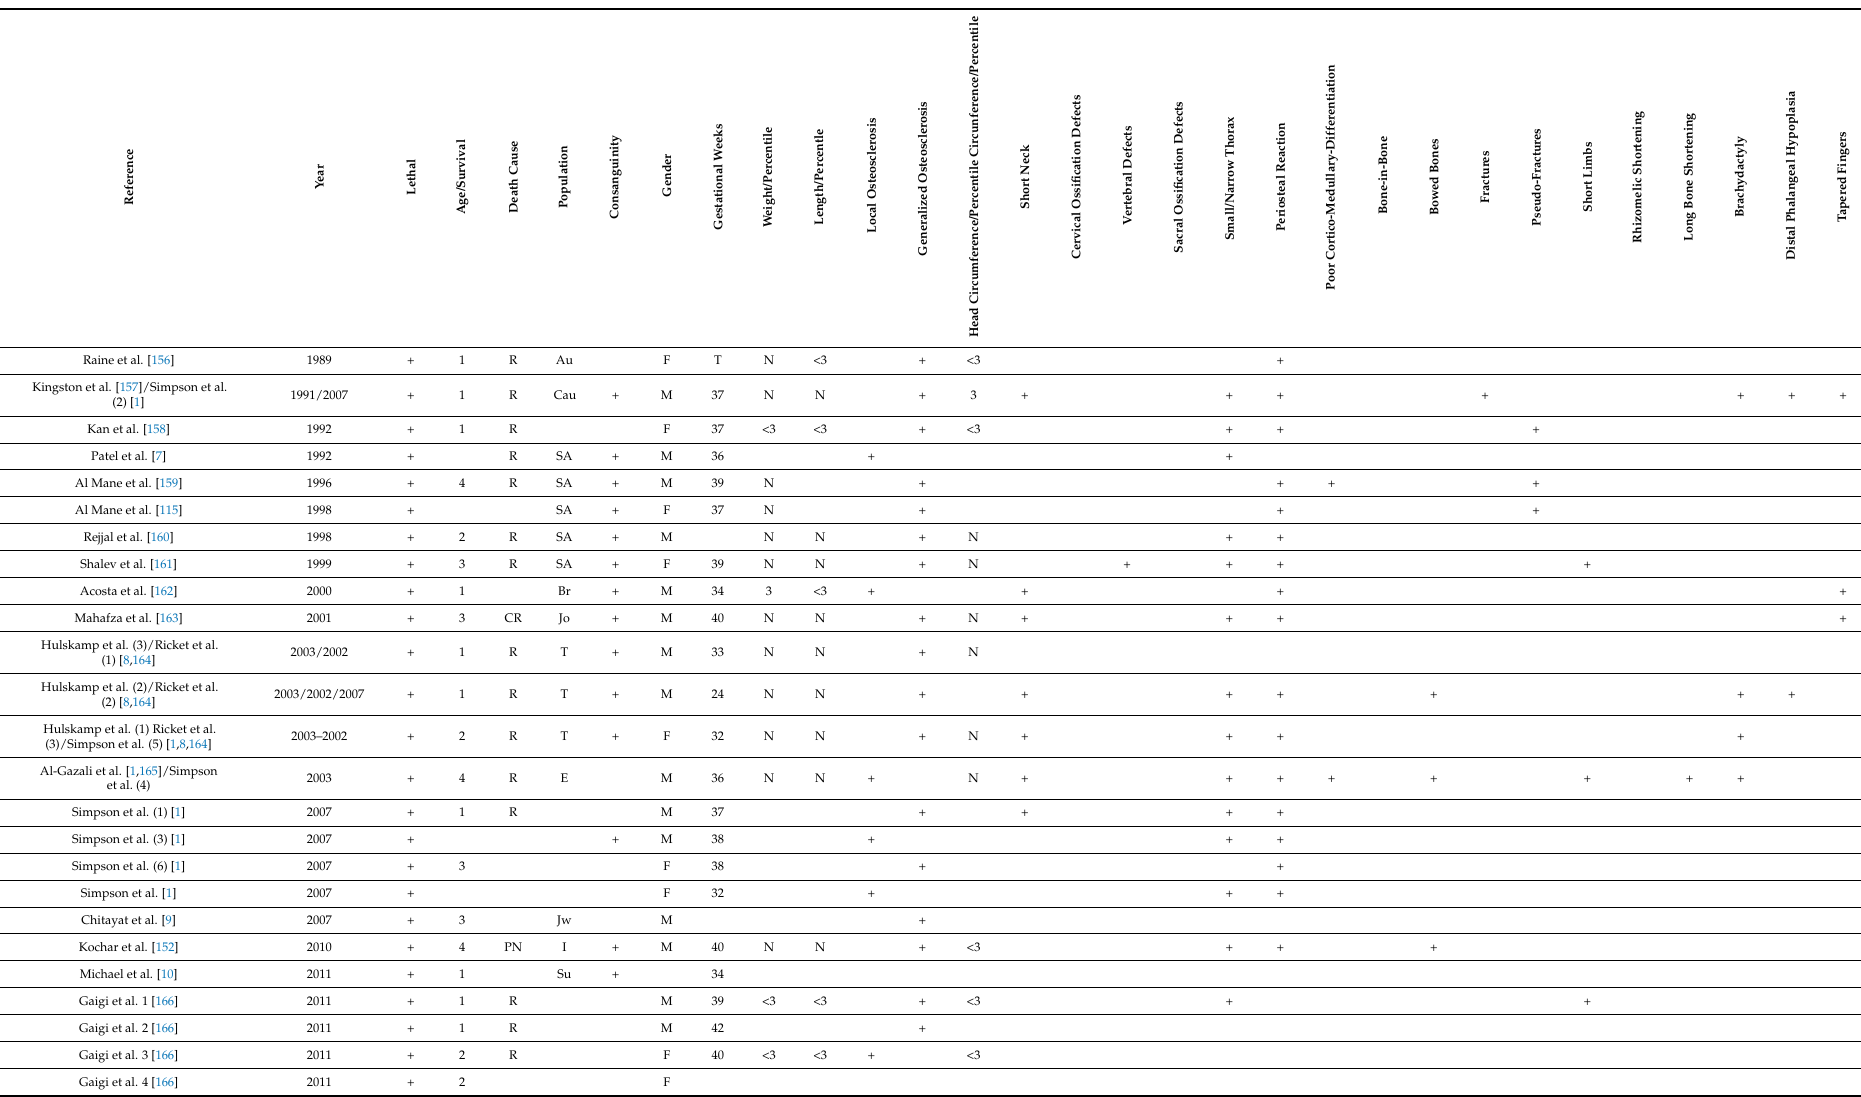
Table 4. Skeletal features of LRS cases.